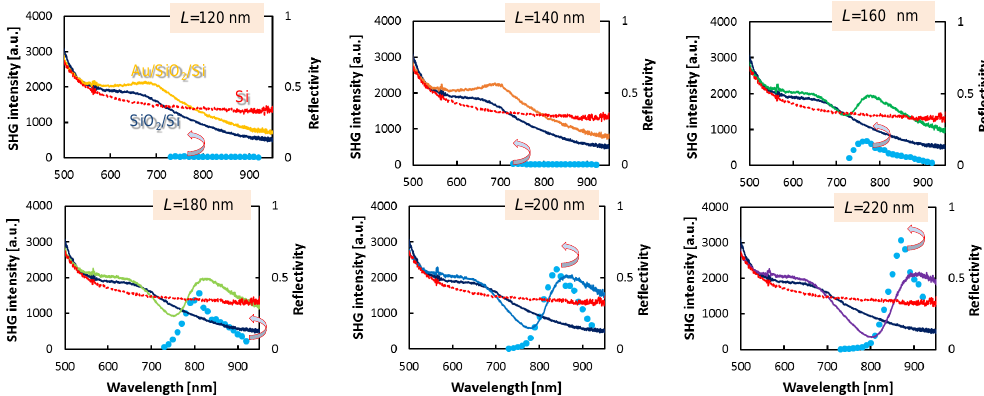
Figure A1. Plots showing experimentally measured SHG excitation spectra from metasurfaces (cyan dots, left-axis) of Au triangular nanoparticles on a SiO 2 /Si substrate with triangle side-lengths, L = 120 nm to 220 nm. Reflectivity spectra R ( λ ) (right-axis) are shown for bare Si (red), Si with SiO 2 (dark blue), and the metasurface for different size L nano-prisms (color coded). The SiO 2 spacer width was the same w = 200 nm. Polarisation of the incident field was horizontal E x .